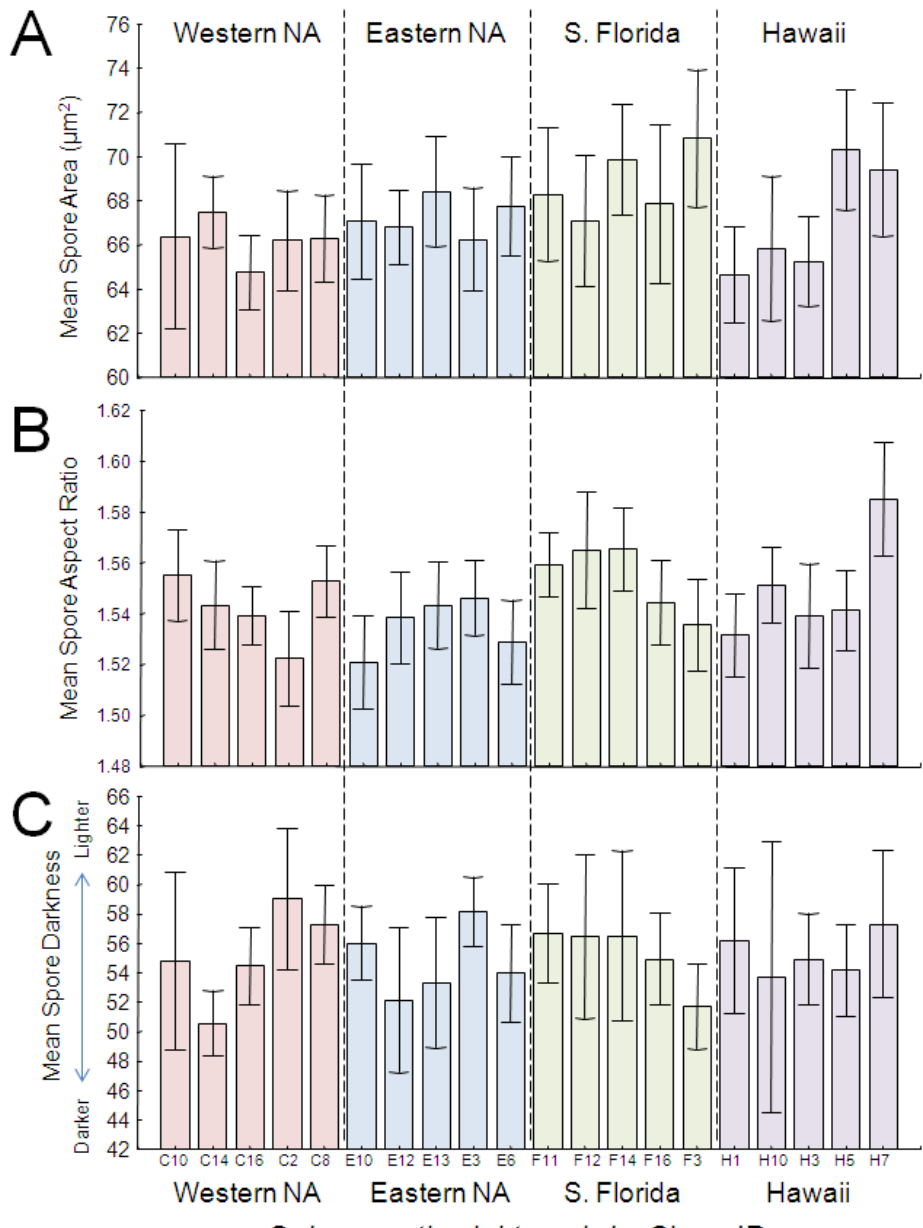
Figure 4. Average spore area ( A ), aspect ratio ( B ) and darkness score ( C ) of OE spores across monarch clones, arranged numerically within each source population. Eastern and western NA are from migratory monarch populations within North America. S. Florida refers to parasites obtained from a year-round resident (non-migratory) population near Miami, FL, USA, and Hawaii refers to parasites from non-migratory monarchs that inhabit the Hawaiian islands. Error bars represent 95%